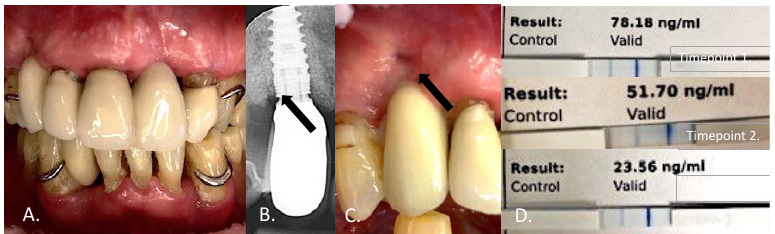
Figure 4. This 89-year-old patient ( A ) showed buccal bone loss, assessed using an intraoral X-ray ( B ), and a gingival fistula at the study implant D13 ( C ). The visual plaque index measured 1/3 at the beginning of the study, with a probing depth of 4 mm. The aMMP-8 value in the peri-implant sulcular fluid was 78.18 ng/mL at the beginning of the study (D) . After two weeks of Lumoral ® dual-light aPDT treatment repeated once a day, the aMMP-value was 51.70 ( D ), after which the Lumoral ® treatment was repeated twice a day for the next two weeks. At four weeks, the aMMP-8 was 23.76 ng/mL, and the visual plaque index measured 0/3. In this patient, bleeding on probing was measured positive though the whole study period, and no change was observed in the probing